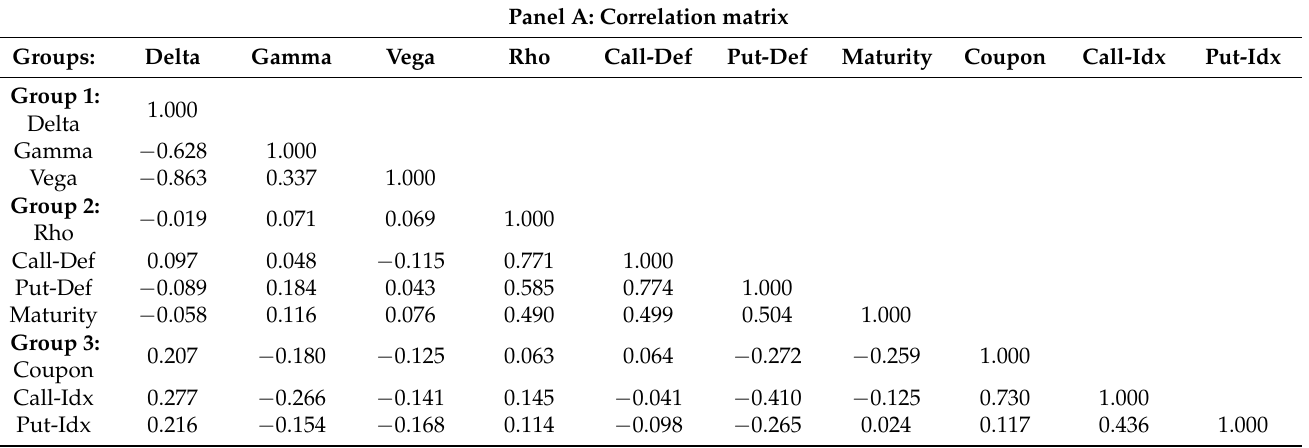
Table 5. Correlation matrix and reduced set of explanatory variables. Panel A: Correlation